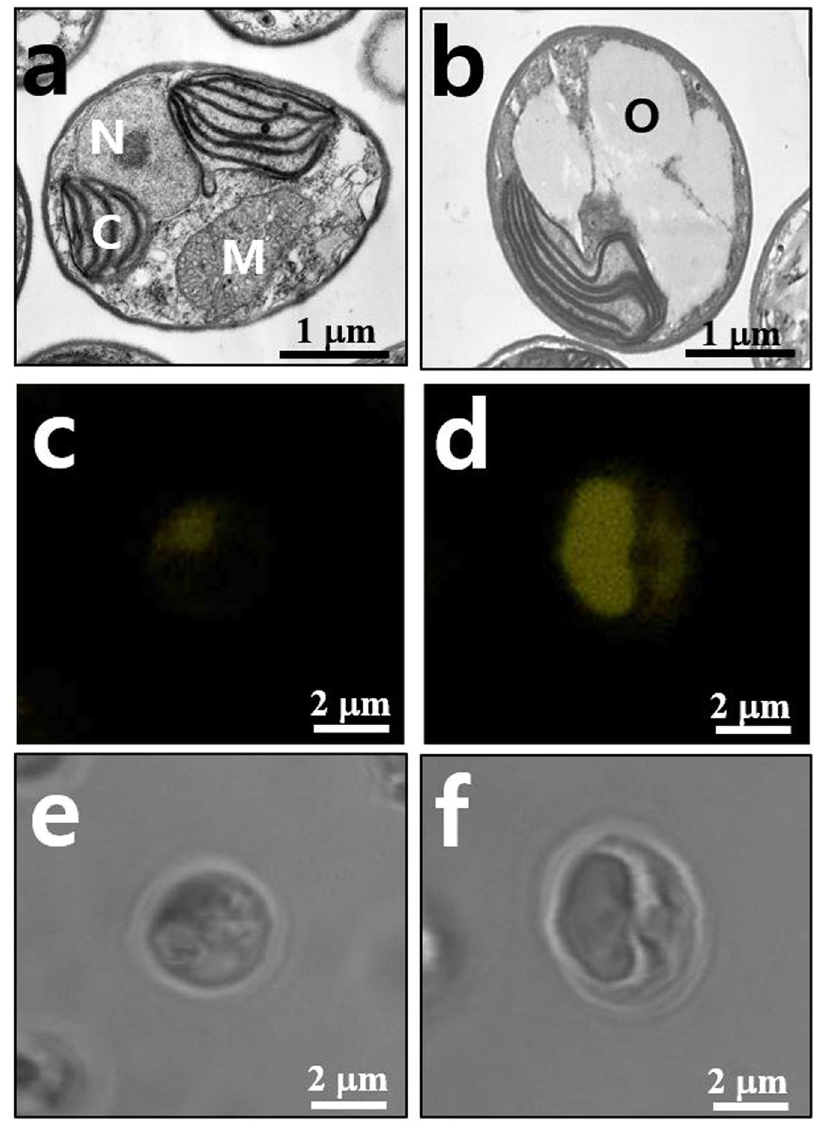
Figure 1. Representative transmission electron microscopy (TEM) ( a , b ), Nile Red fluorescence ( c , d ), and bright field ( e , f ) images of N. salina cells grown under N + and N − conditions for 2 days. Cells were fixed and then subjected to TEM analysis. Organelles are indicated as follows: N, nucleus; M, mitochondria; C, chloroplast; O, putative oil bodies. Oil bodies stained with Nile Red are visible (yellow) inside the cells.